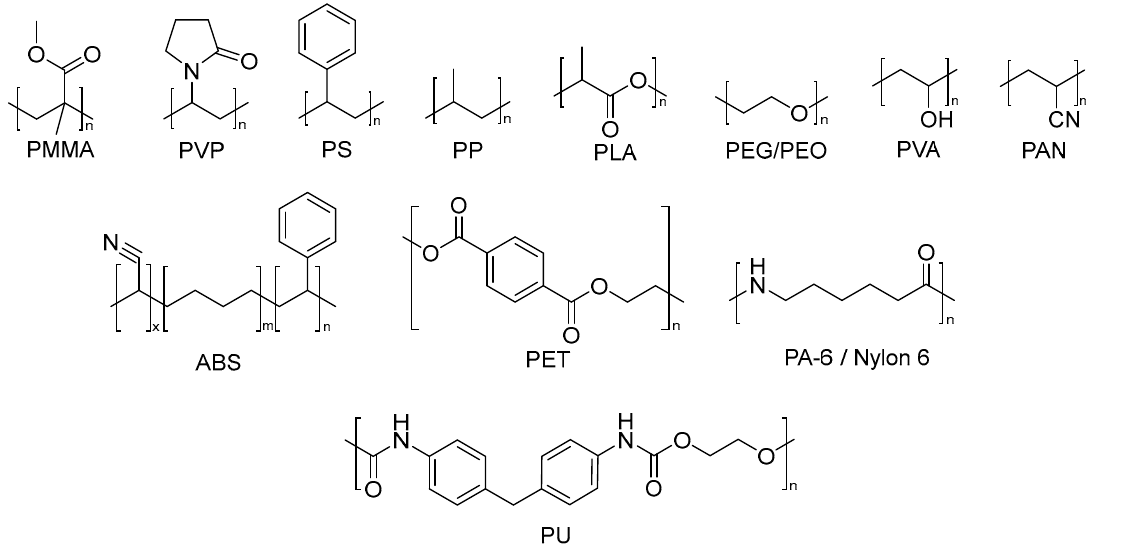
Figure 2. Molecular structure of the main polymer structures used for the development of electrospun nanofibers.